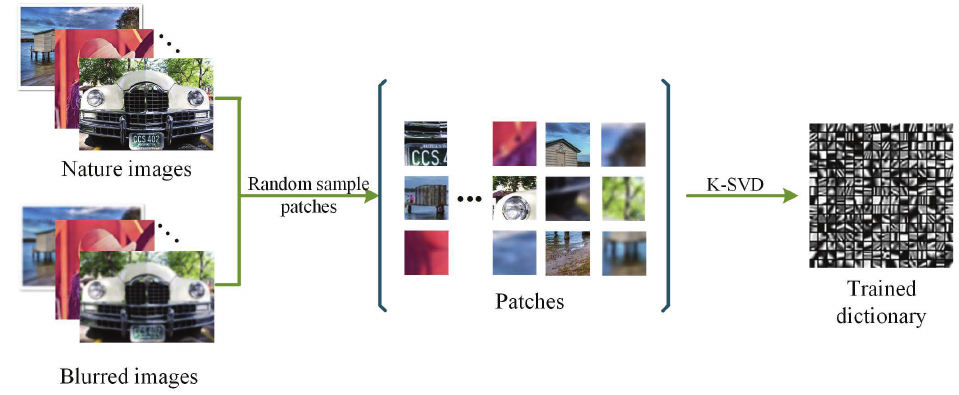
Figure 6. The general process of training a